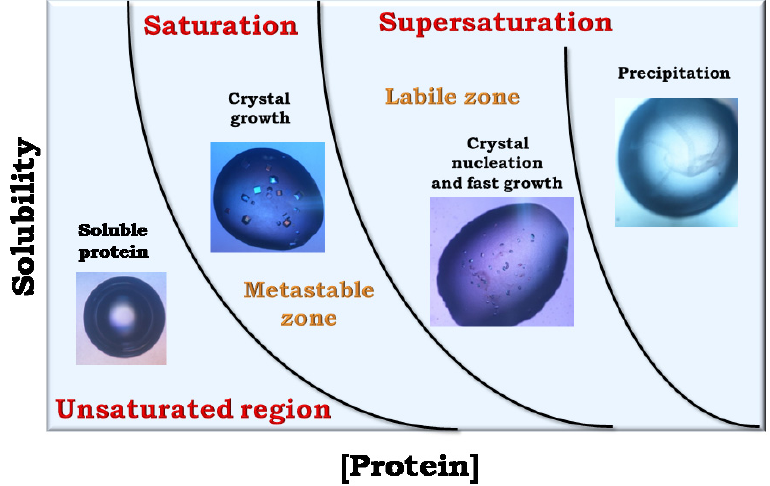
Figure 2. Schematic solubility curve for a protein, as a function of the protein